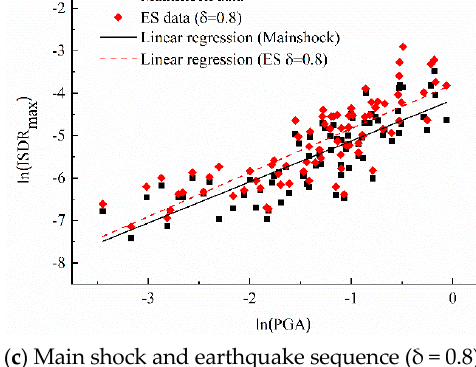
Figure 14. PSDM under main shock and earthquake sequences. Table 5. Regression parameters for the PSDMs.